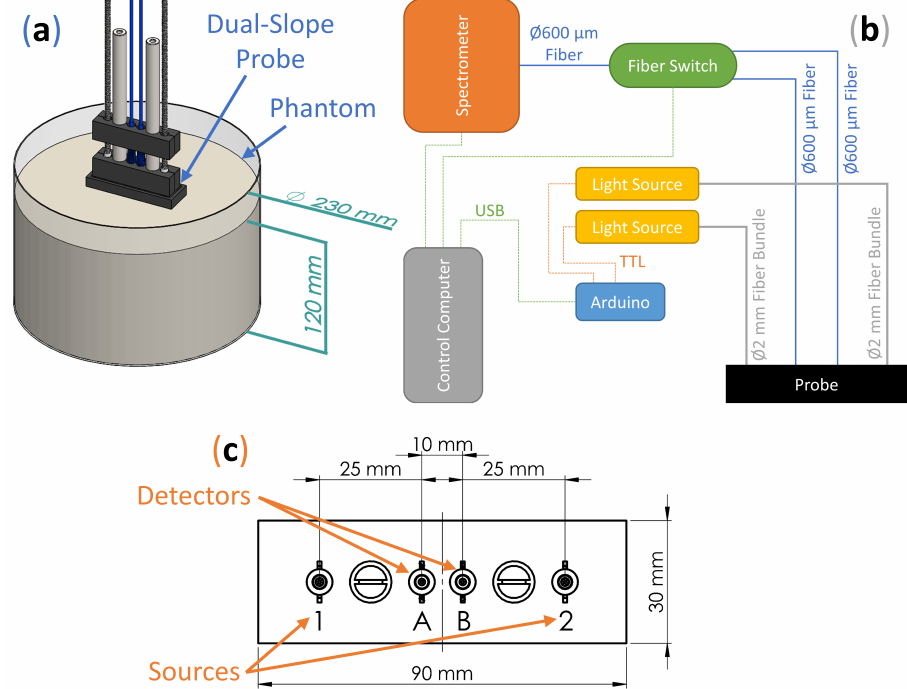
Figure 2. Broadband diffuse reflectance spectroscopy methods to achieve measurements of absolute absorption spectra. ( a ) Render of diffuse reflectance spectroscopy probe on a diffuse optical phantom. ( b ) Schematic of dual-slope diffuse reflectance spectroscopy device. Acronyms: Universal Serial Bus (USB) and Transistor-Transistor Logic (TTL). ( c ) Schematic of the source (1 and 2) and detector (A and B) positions on the dual-slope diffuse reflectance spectroscopy